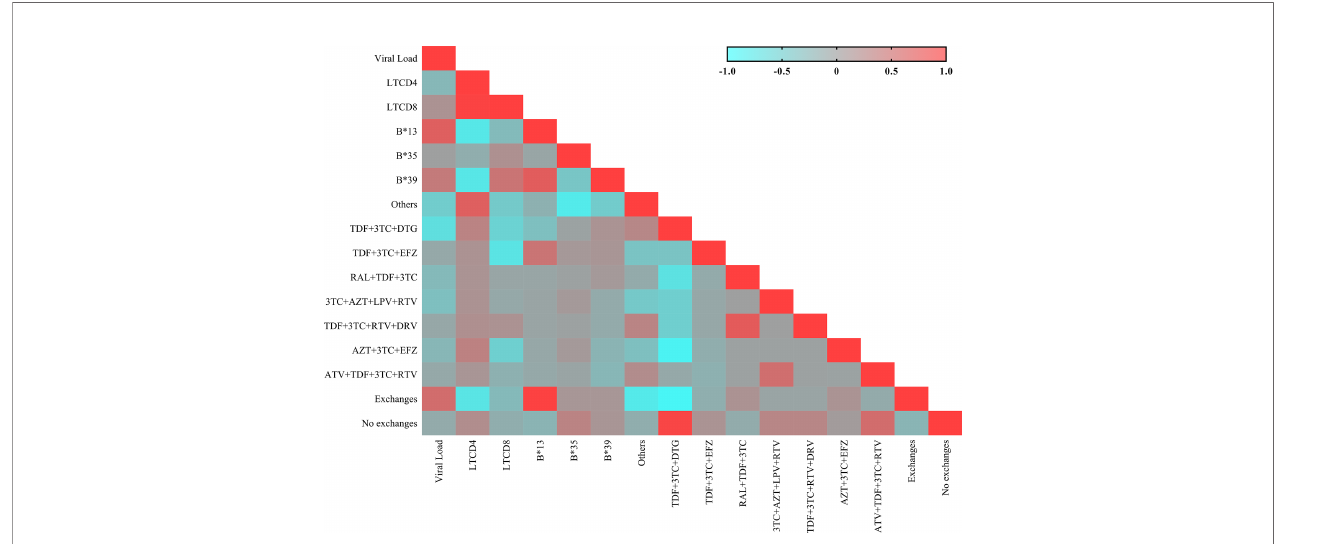
FIGURE 6 | Heatmap showing the matrix of correlations between the immunovirological and genetic variables. Each square represents the Spearman coef fi cient of the correlation between two variables. Negative and strong correlations have a coef fi cient between -1.0 and -0.5; negative and weak correlations have a coef fi cient between -0.5 and 0; positive and weak correlations have a coef fi cient between 0 and 0.5; and positive and strong correlations have a coef fi cient between 0.5 and